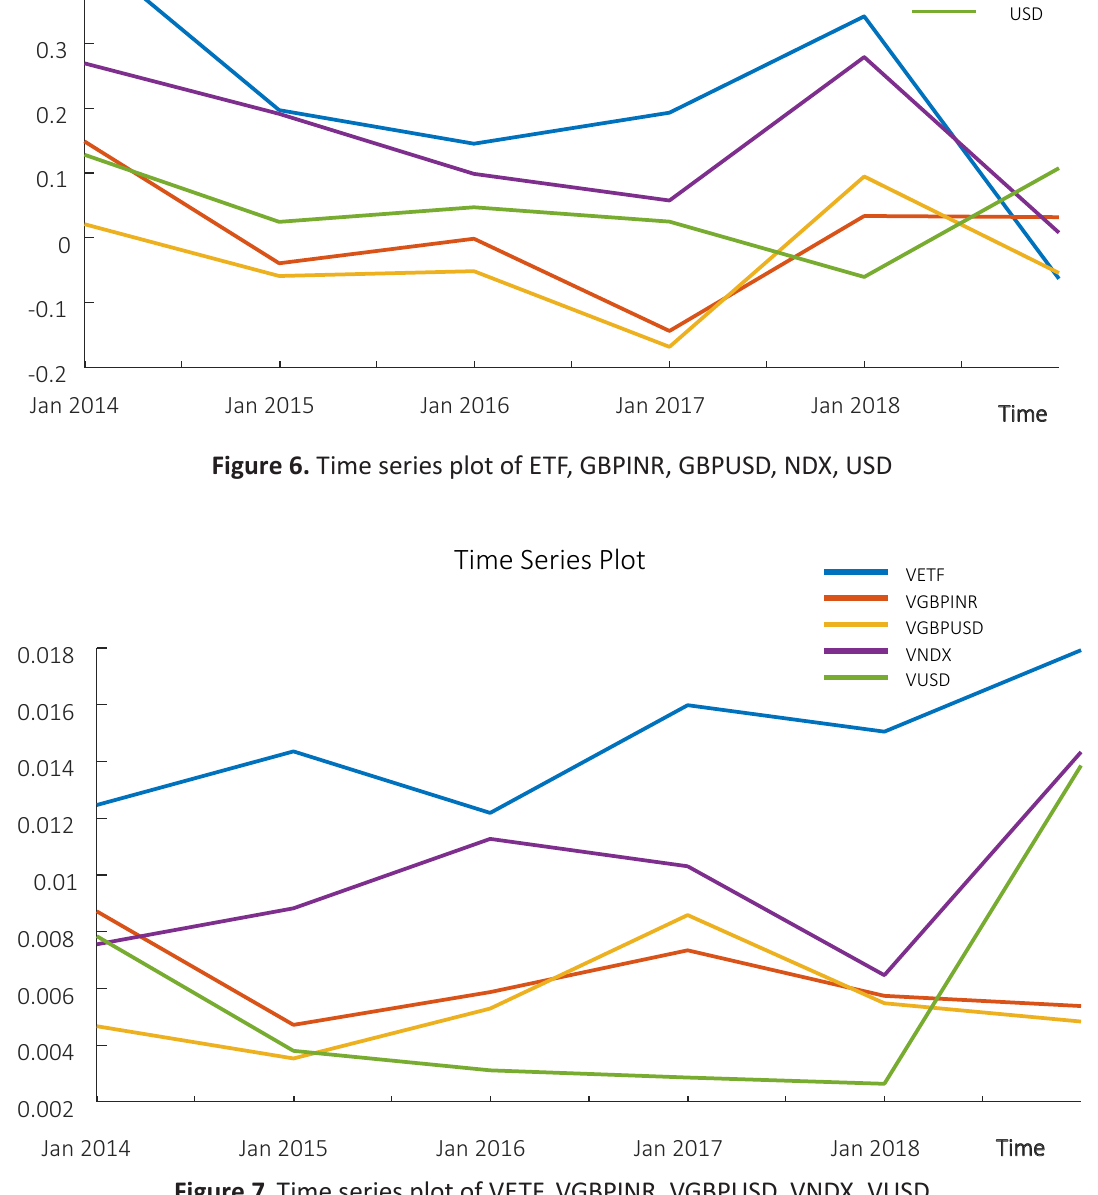
Figure 7. Time series plot of VETF, VGBPINR, VGBPUSD, VNDX,